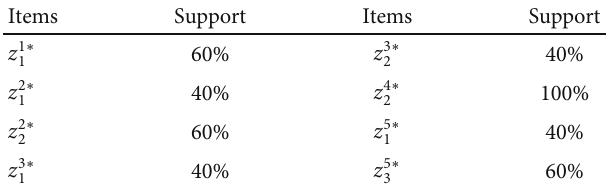
Table 5: Frequent item set L